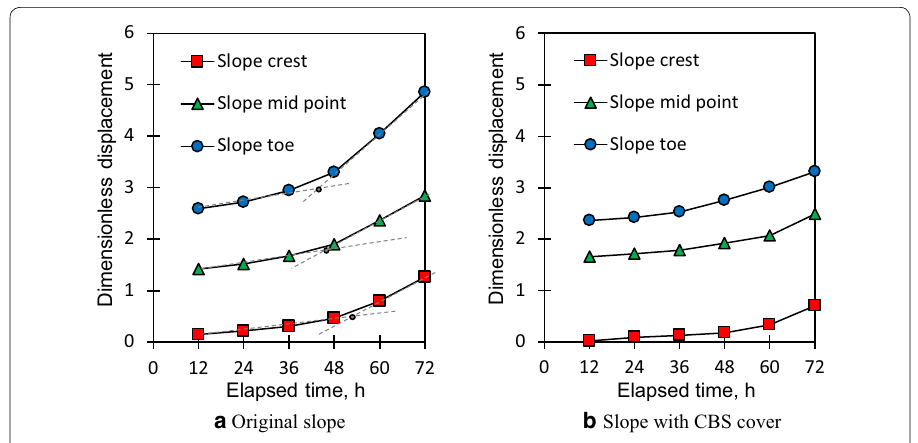
Fig. 18 Dimensionless displacement of the original